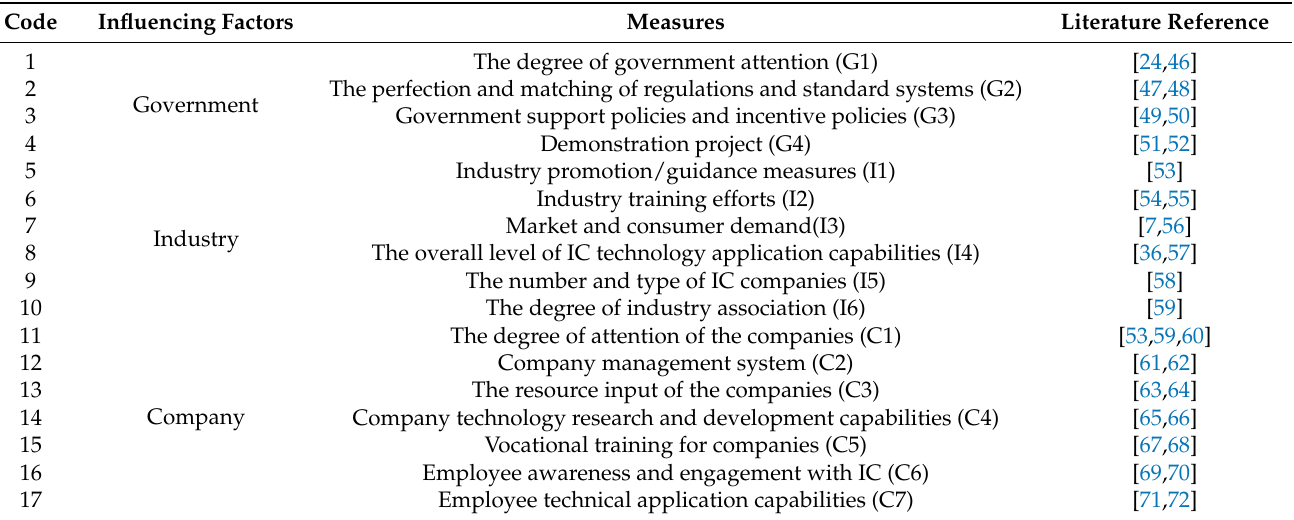
Table 1. Influencing factors for IC